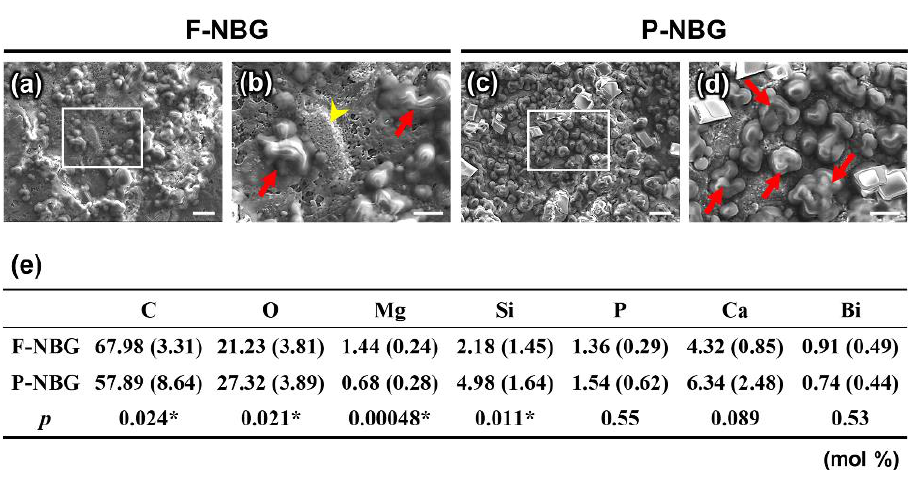
Figure 3. Representative ultrastructures ( a – d ) and average elemental compositions ( e ) of the surface of as-prepared flowable and putty-form Nishika Canal Sealer BG Multi (F-NBG and P-NBG). ( b , d ) Higher-magnification views of boxed regions in ( a ) and ( c ). Arrows in ( b ) and ( d ) indicate bioactive glass-like irregular shaped crystals. Arrowheads in ( b ) indicate a bismuth subcarbonate-like rod-shaped crystal. Data for elemental composition are shown as the mean (SD) % of six samples. Asterisks indicate p < 0.05 (unpaired t -test, n = 6). C: carbon; O: oxygen; Mg: magnesium; Si: silicon; P: phosphorus; Ca: calcium; Bi: bismuth. Scale = 10 μm ( a , c ), 5 μm ( b , d ).